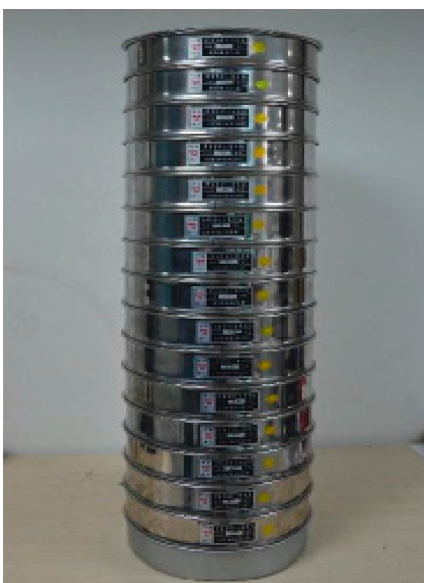
Figure 8: Vibration sieve machine.